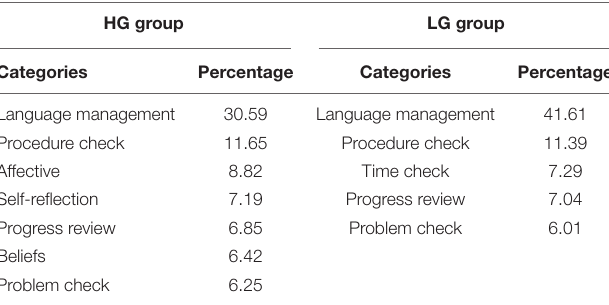
TABLE 1 | Dominant pedagogical thought categories for the HG and LG groups of teachers. HG group LG group